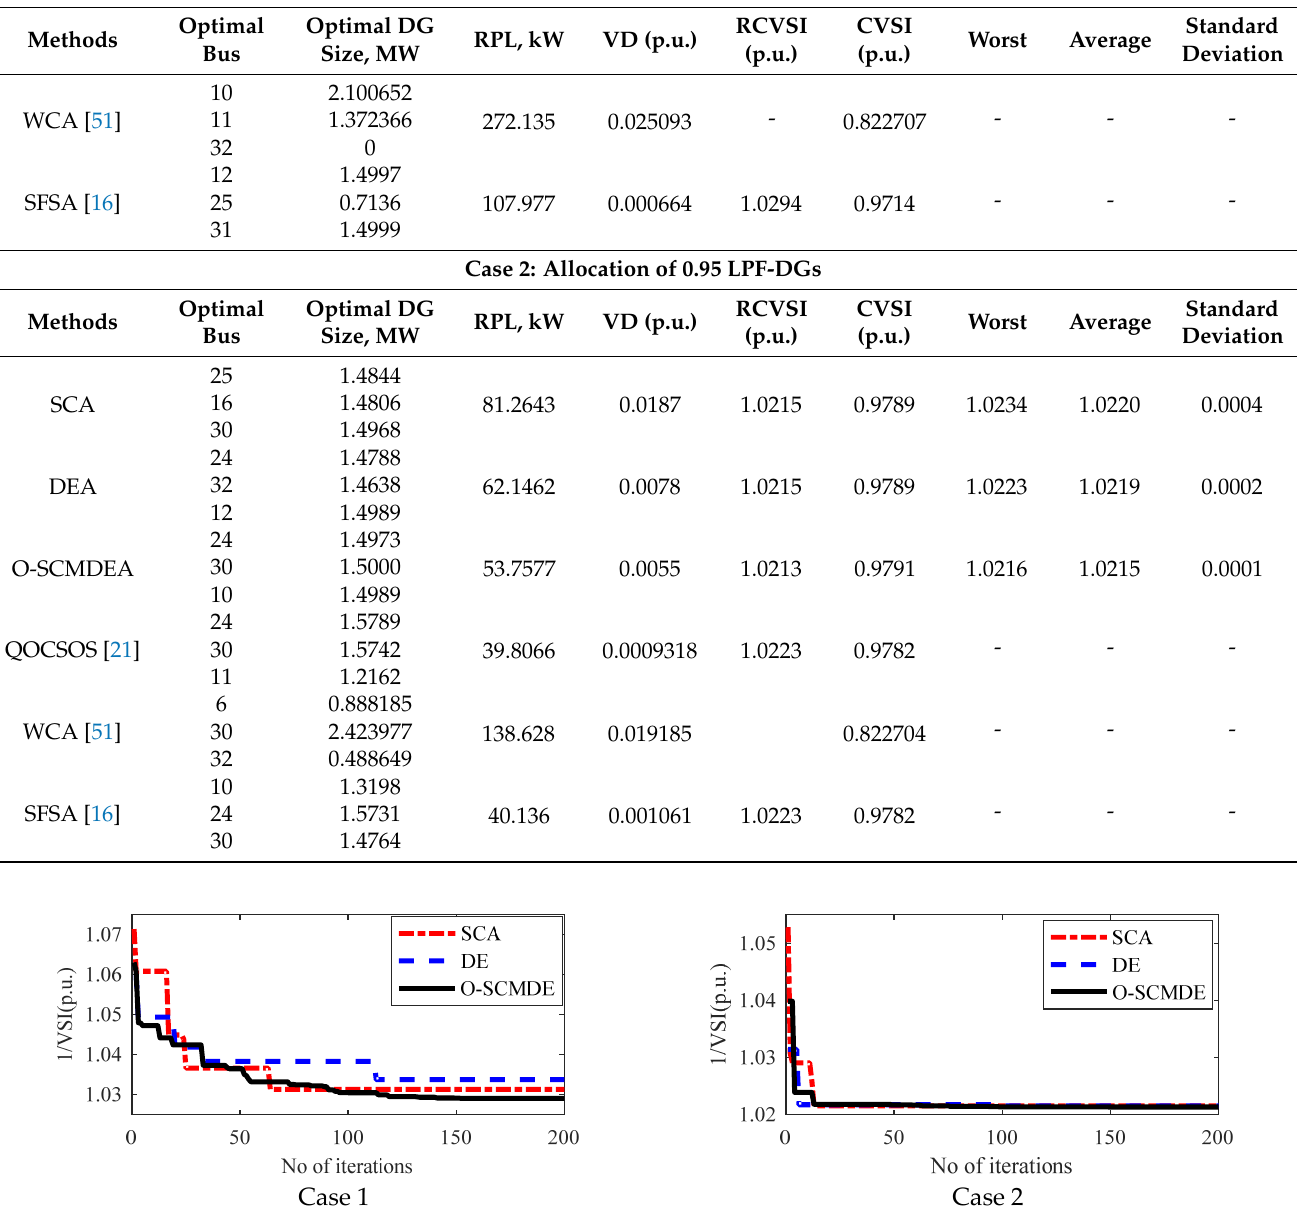
Figure 4. Comparison of convergence characteristic of the SCA, DEA and O-SCMDEA for both cases of scenario III of the 33 bus system.